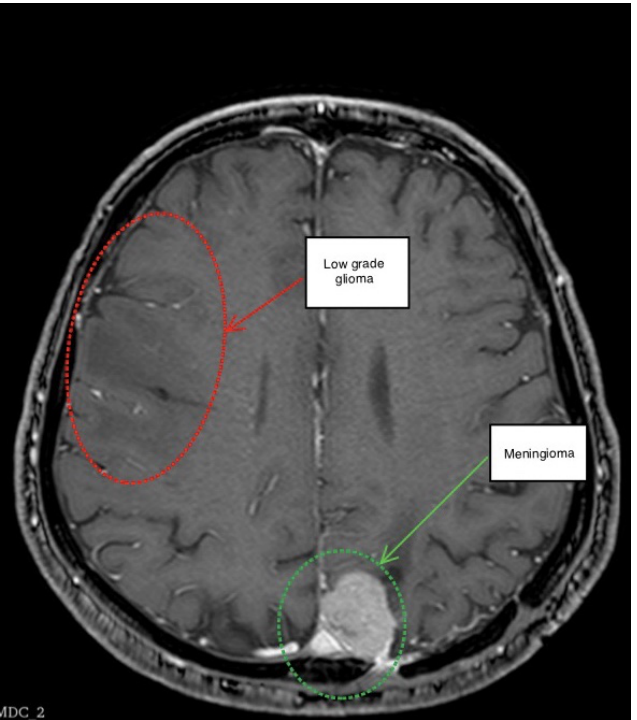
Figure 3. Experimental assessment, first scenario. A patient with two pathologies.